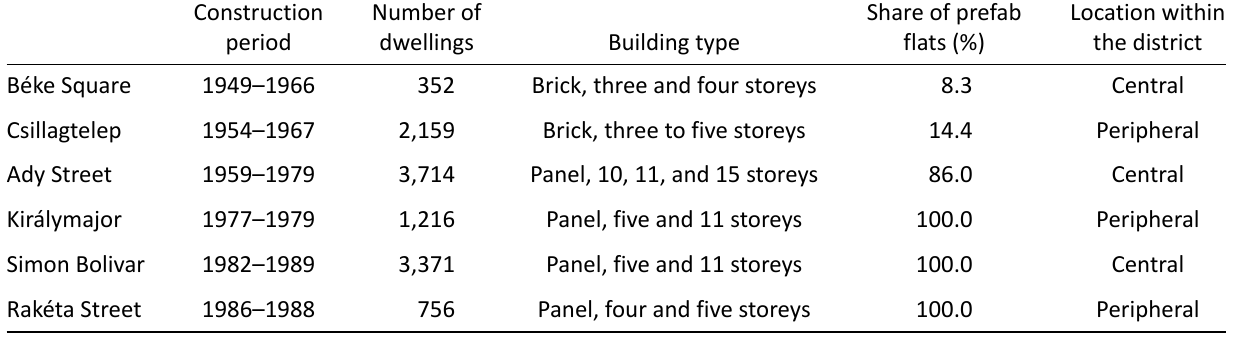
Table 2. Characteristics of the case study areas.